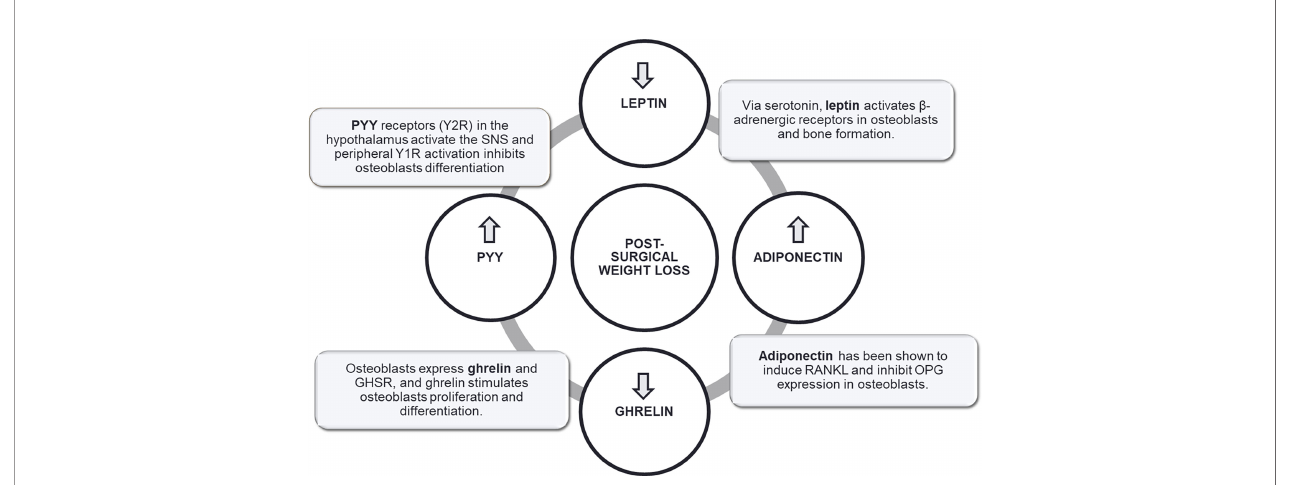
FIGURE 5 | Putative mechanisms linking post-bariatric surgery weight loss to changes in bone